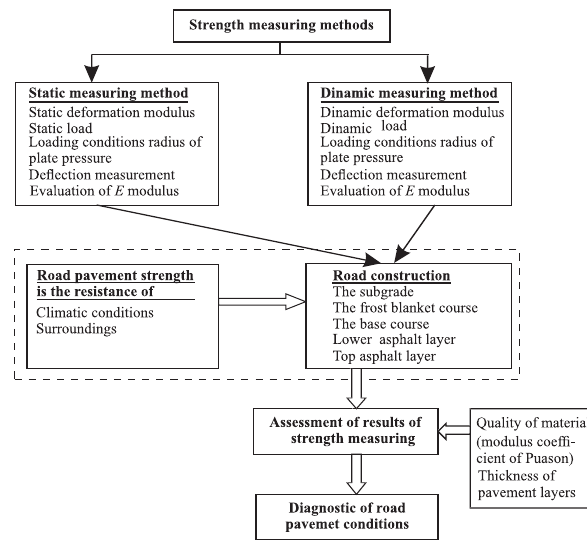
Fig. 1. Strength measuring methods based on deflection